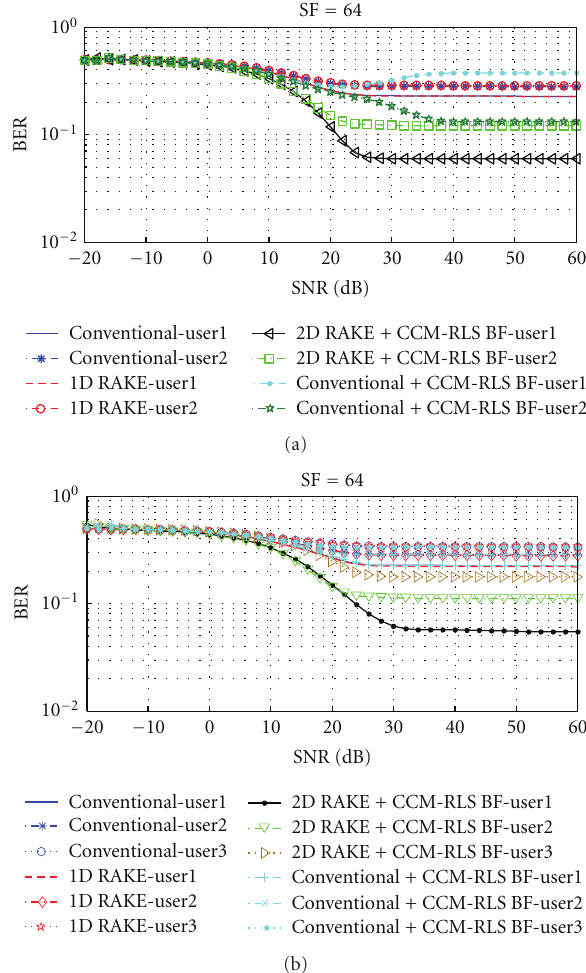
Figure 4: Performance of di ff erent conventional and proposed WCDMA receivers considering 4-element antenna array in AWGN channel for (a) 2 users, (b) 3 users.